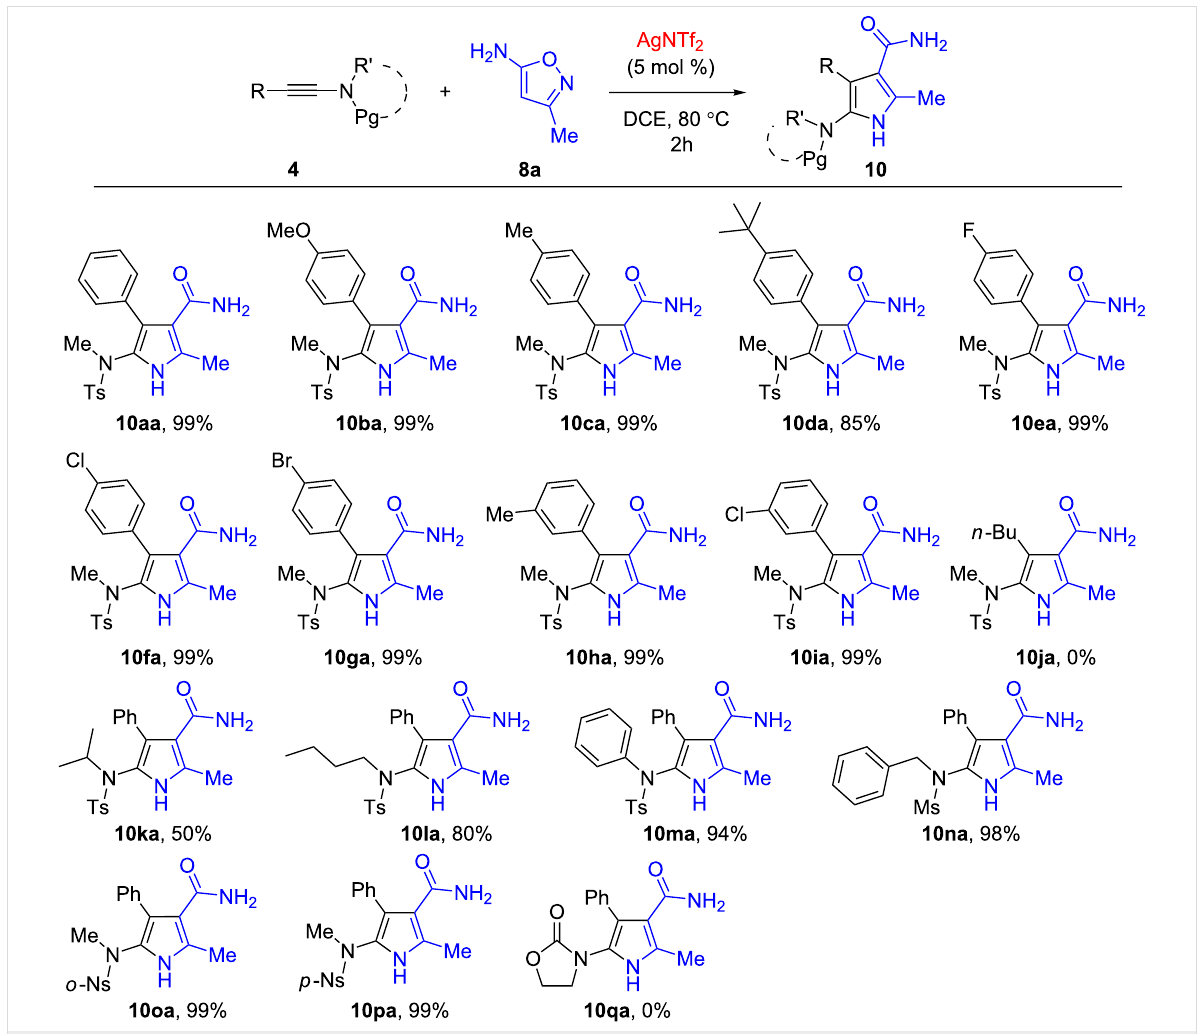
Figure 2: Scope with regard to ynamide 4 . All reactions were carried out with ynamide 4 (0.2 mmol), isoxazole 8 (0.22 mmol, 1.1 equiv) with AgNTf 2 (5 mol %) in DCE (2.0 mL) at 80 °C, unless otherwise noted. Isolated yields are